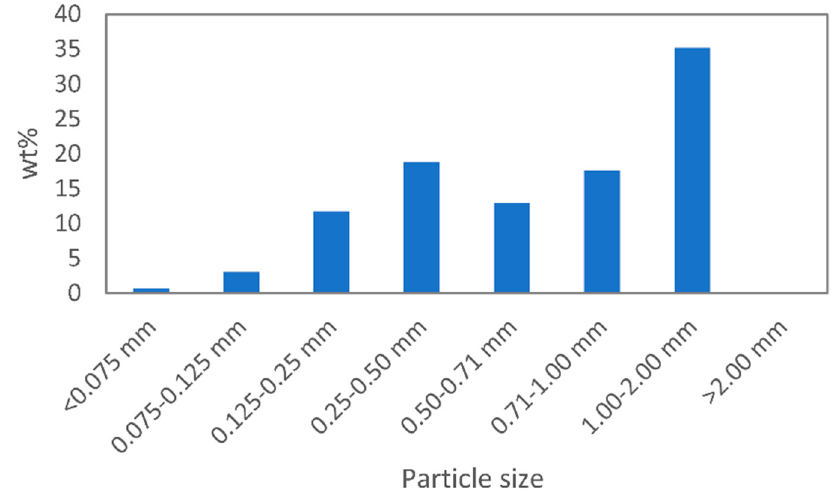
Figure 1. Particle size distribution of the ground EPDM rubber.